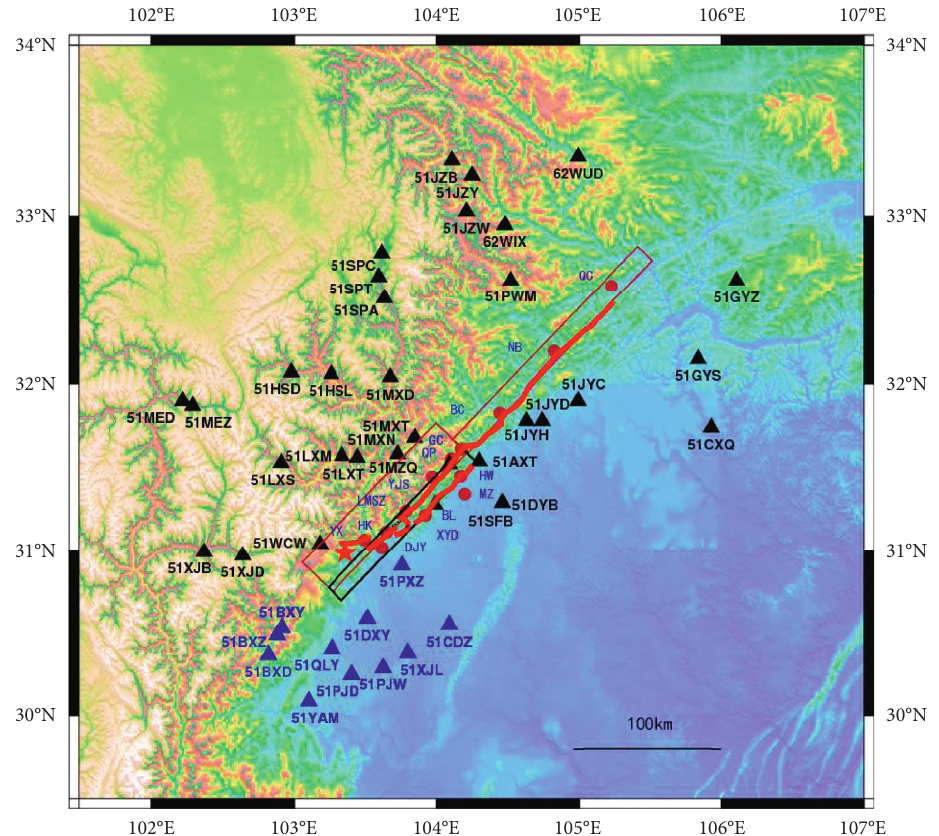
Figure 1: The locations of the Wenchuan earthquake and 43 strong-motion stations. Stations marked by blue triangles are located behind the rupture direction. YX: Yingxiu, HK: Hongkou, LMS: Longmenshan, YJS: Yuejiashan, QP: Qingping, GC: Gaochuan, BC: Beichuan, NB: Nanba, QC: Qingchuan, BL: Bailu, and HW: